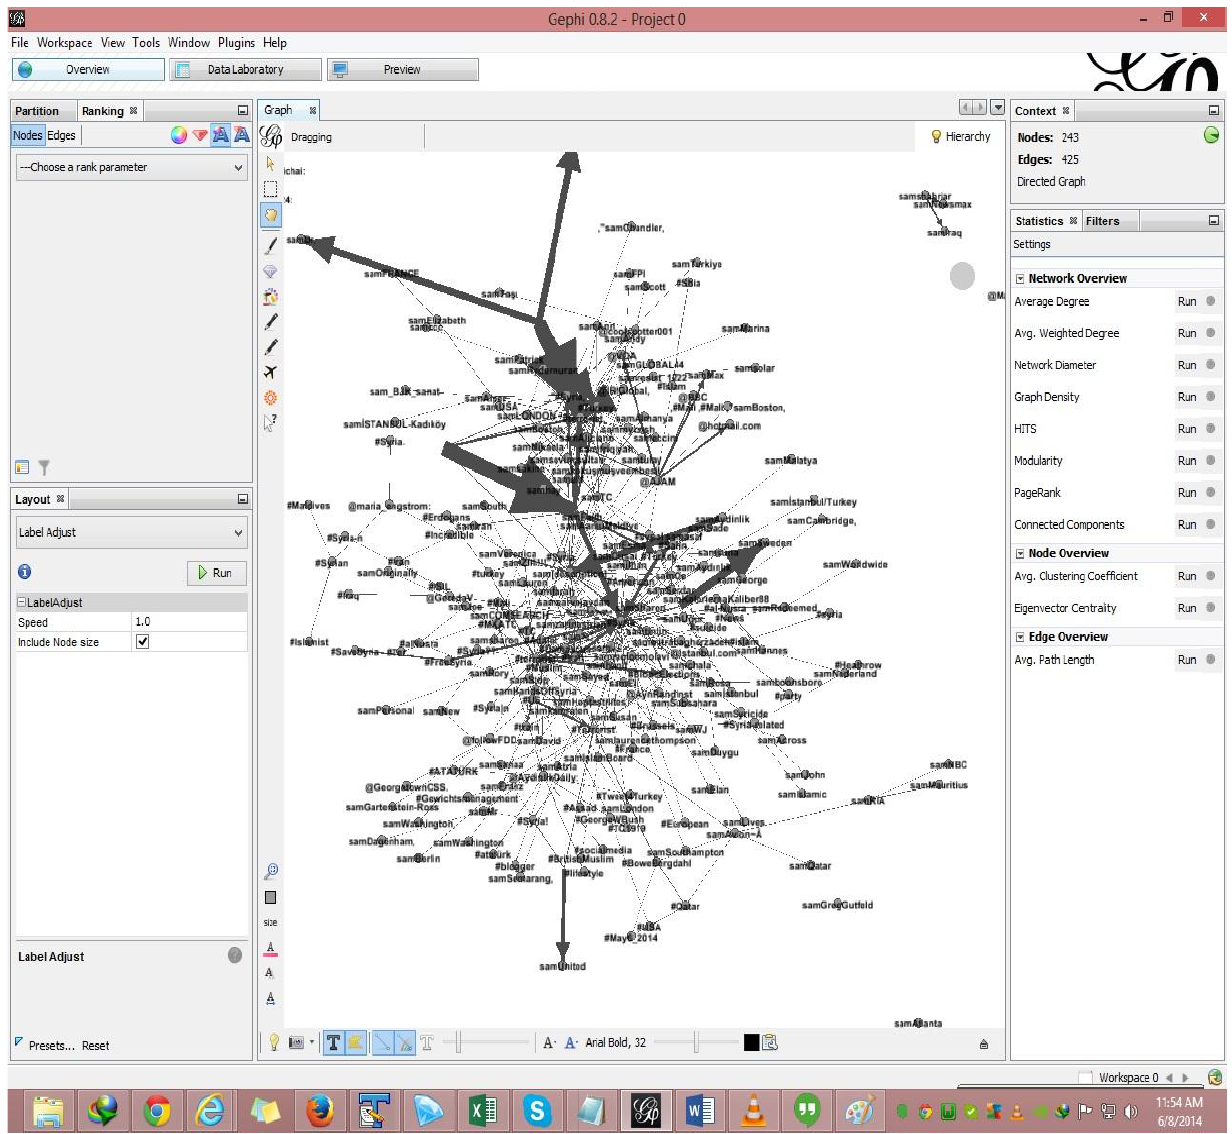
Figure 6. Social Network Analysis of Users and communities on the basis of Tweeted Structured